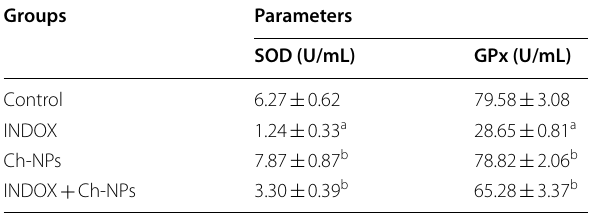
Values expressed as mean standard error (SE) (10 rats/group) ± a Significant changes when compared with the control group at P < 0.05 b significant changes when compared with the INDOX group at P < 0.05